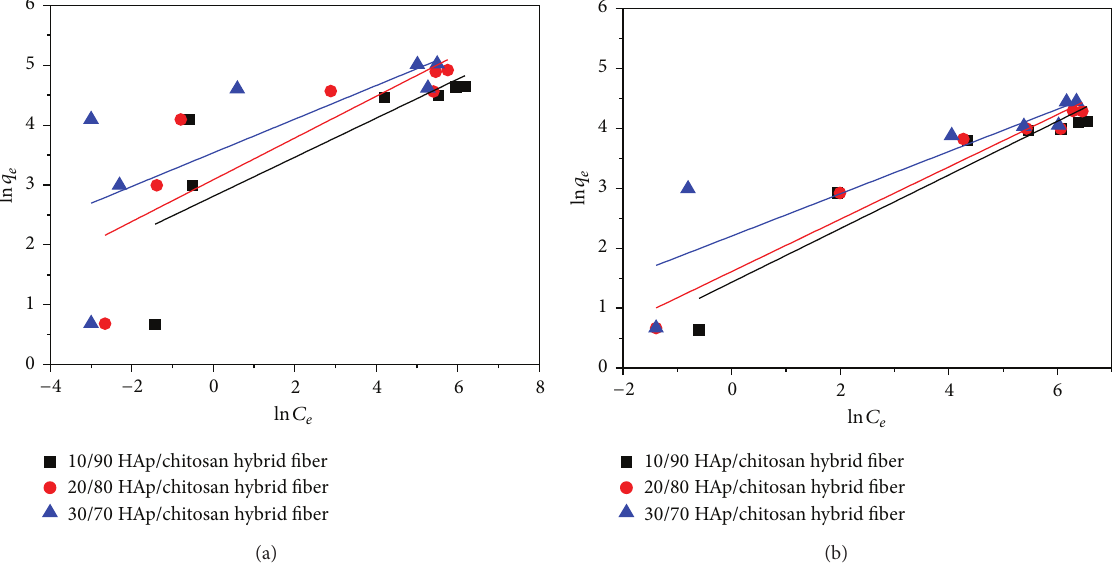
Figure 5: Freundlich isotherm model for adsorption of (a) Pb 2+ and (b) Cd 2+ on hybrid fibers with different HAp/chitosan ratio (10/90 (square), 20/80 (circle), and 30/70 (triangle)).